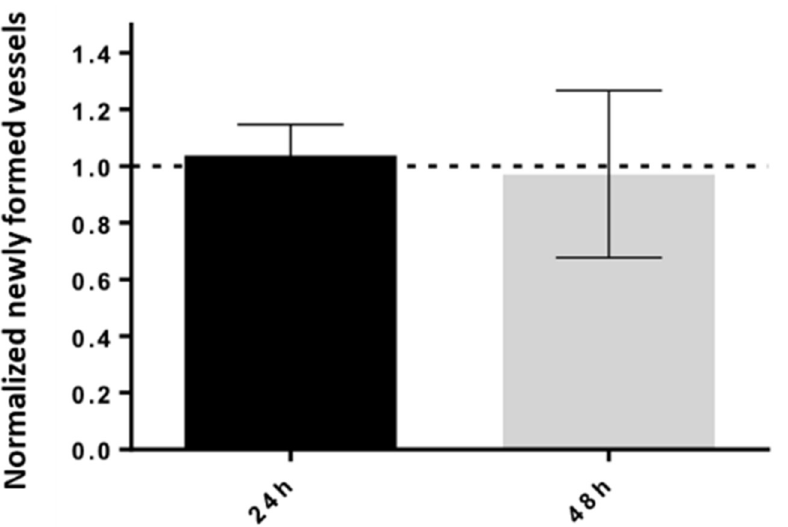
Figure 12. Newly formed vessels after 24 h and 48 h incubation with IC 50 of JHOR11. Values are normalized to the number of vessels at 0 h and obtained after incubation with 0.1% ( v / v ) DMSO at the respective time point in the same embryo. The dotted line at 1.0 represents the value of the DMSO sample normalized to the respective number of vessels at a 0 h time point. Bars represent the average ± SD of six chicken embryos (biological independent assays).